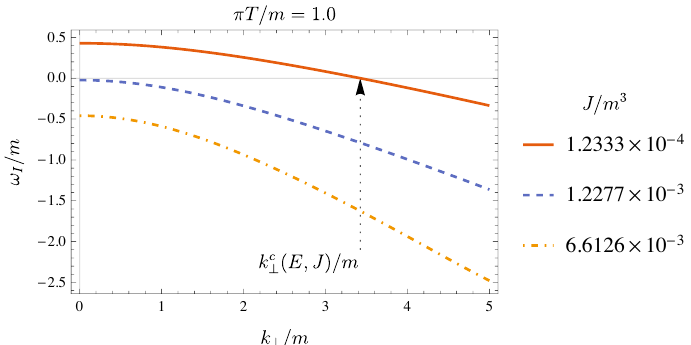
Figure 13 . ω I /m as functions of k ⊥ /m for several J/m 3 at πT/m = 1 . 0000 . For J/m 3 = 1 . 2333 × 10 − 4 , ω I /m goes across zero at k ⊥ /m ≈ 3 . 4 . Such a critical wavenumber k c and J of the background solutions.